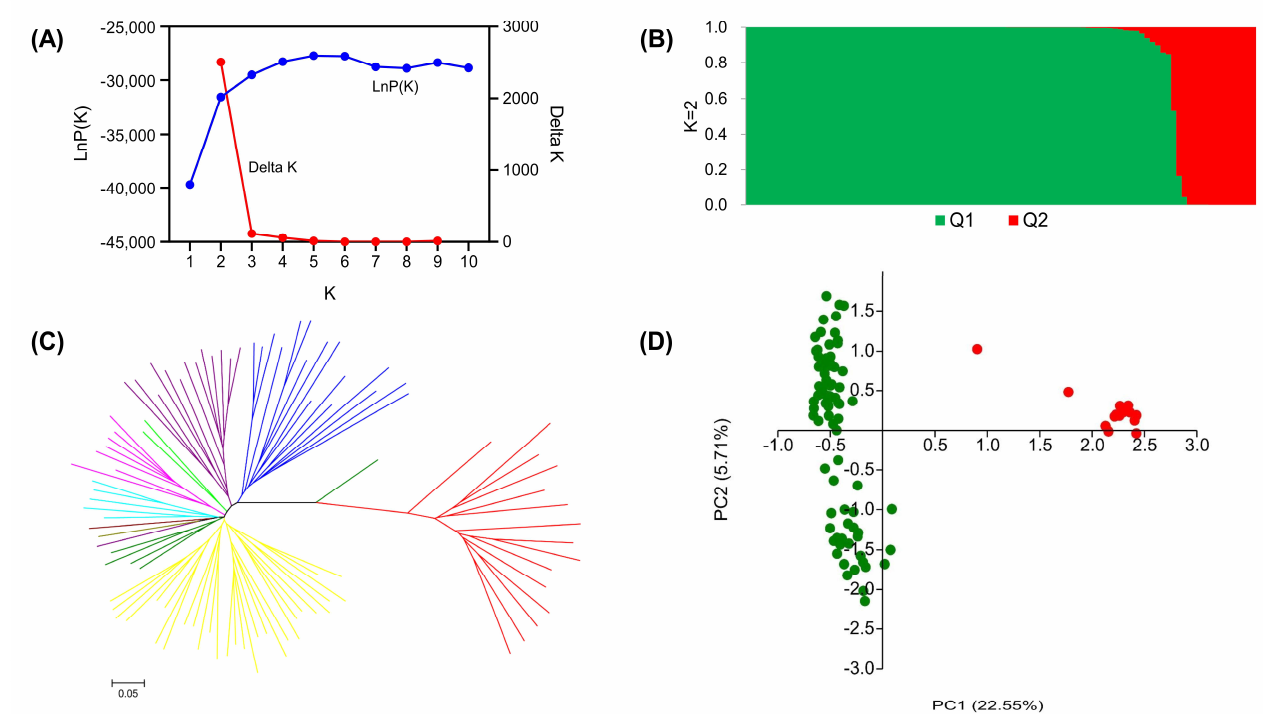
Figure 1. Population structure analysis using Bayesian clustering ( A , B ), neighbor joining ( C , the red branches represent japonica accessions, and the other color branches represent indica accessions), and the principal component ( D ) method.